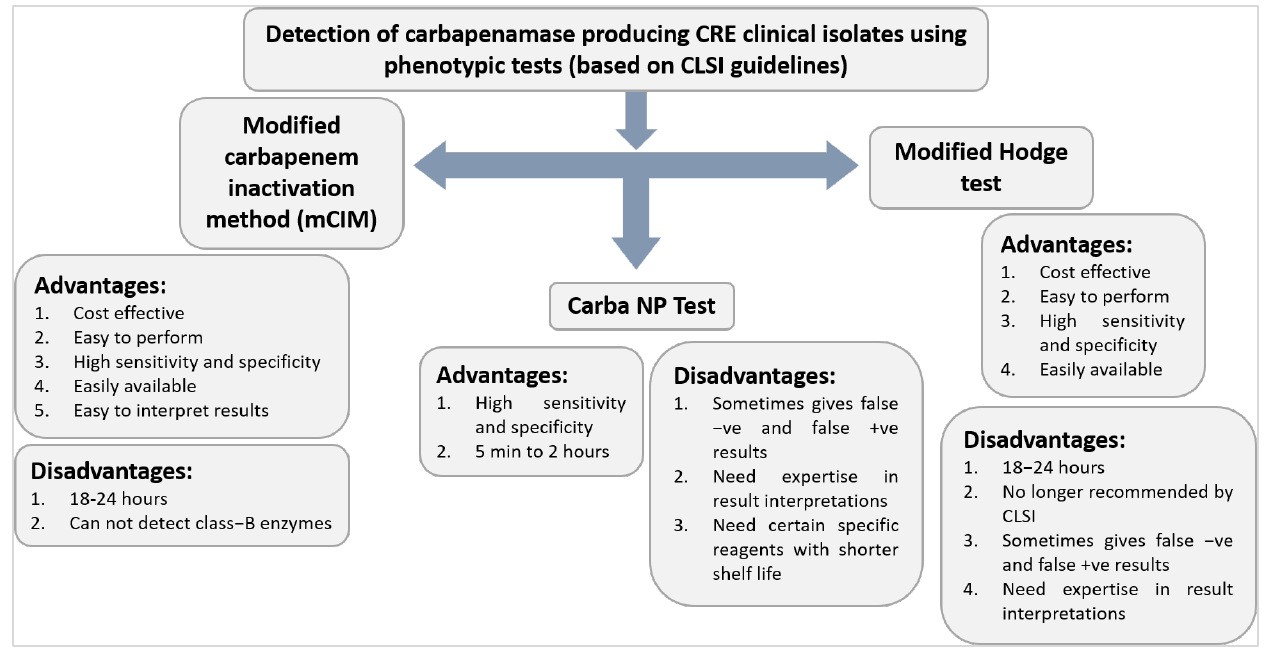
Figure 4. Characteristics of certain phenotypic tests (based on CLSI guidelines) for the detection of carbapenemase-producing CRE clinical isolates.